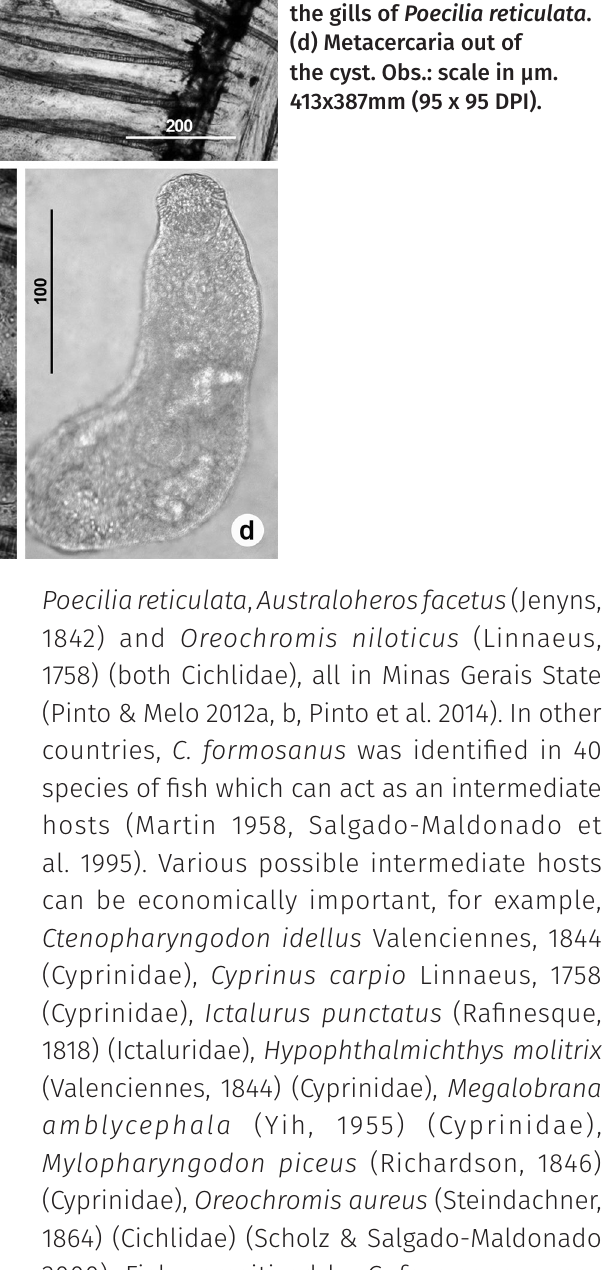
Figure 1. Centrocestus formosanus (a) Cercaria obtained from Melanoides tuberculata collected in Parque do Ingá, Maringá. (b) Gills of Poecilia reticulata infected with metacercaria. (c) Metacercaria obtained from the gills of Poecilia reticulata . (d) Metacercaria out of the cyst. Obs.: scale in μm. 413x387mm (95 x 95